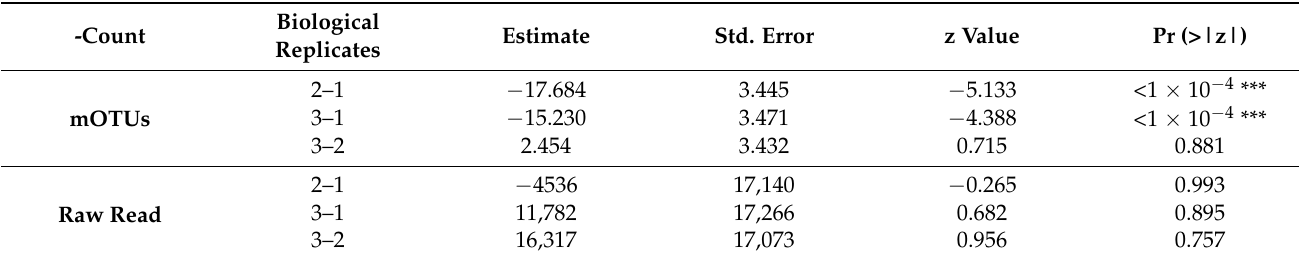
Table A3. Multcomp Tukey test showing a correlation between biological replicates taken from a sediment core in the shown order.